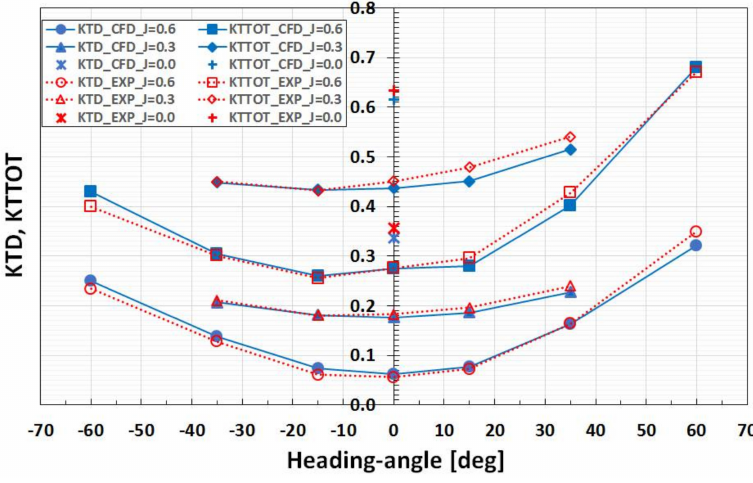
Figure 6. Measured (red) and computed (blue) duct thrust, KTD, and total unit thrust, KTTOT, at different heading angles and loading